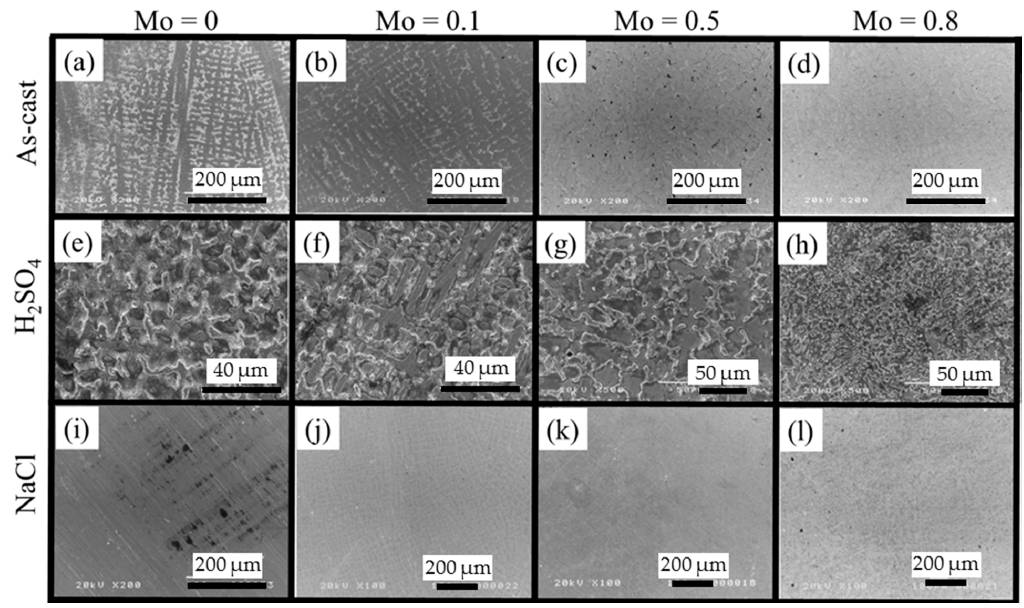
Figure 13. Corrosion and pitting of CoCrFeNiTiMo x ( x = 0, 0.1, 0.5, and 0.8) alloys ( a – d ) As-cast, ( e – h ) after corrosion in H 2 SO 4 , ( i – l ) after corrosion in NaCl [42] (reprinted with permission from